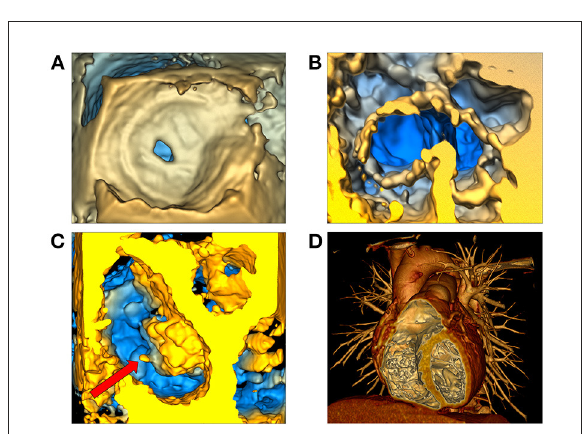
FIGURE6 Volume rendering of 3D echocardiographic and tomographic data. (A) Visualization of an atrial septal defect in the echo volume render module in SlicerHeart from a right atrial view; (B) Visualization of a complete common atrioventricular canal valve in diastole (ventricular view in SlicerHeart); (C) Left atrial view of an aortic valve and a mitral valve with anterior leaflet prolapse and a ruptured chord which is visible as indicated by the red arrow; (D) CT image of a normal anatomic heart cropped anteriorly to visualize the right atrium and ventricle and the left ventricle using volume rendering in 3D Slicer. CT, Computed Tomography.